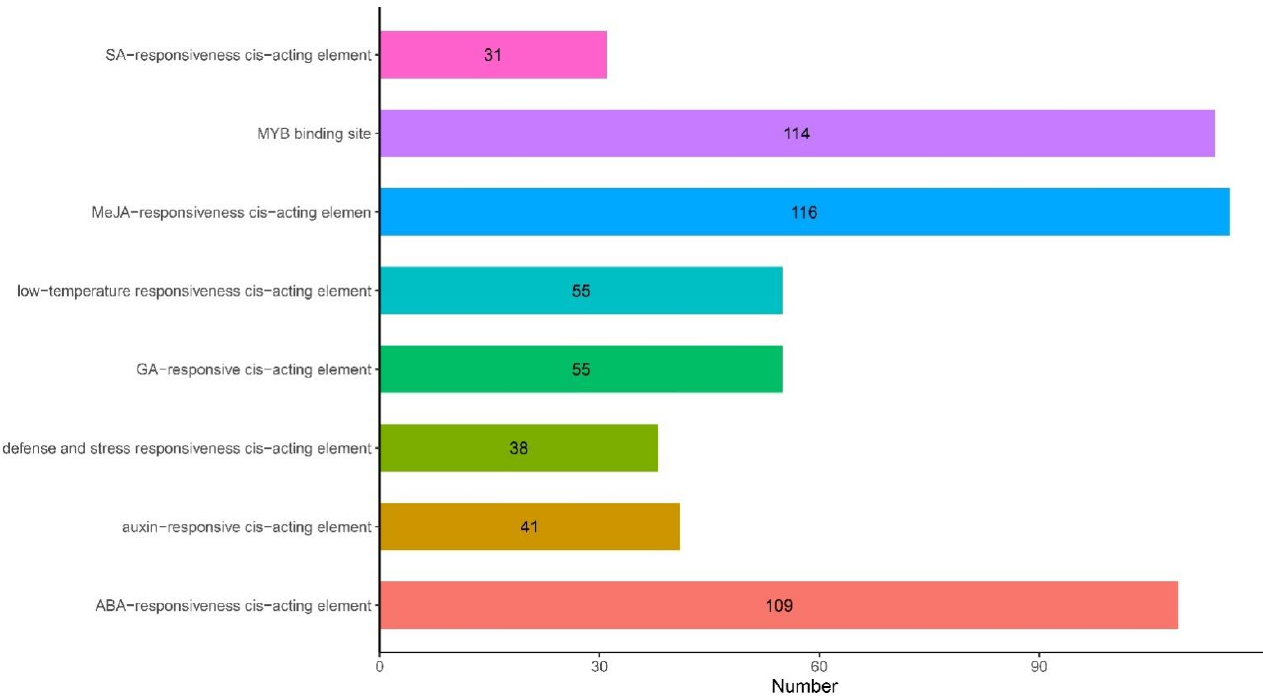
Figure 4. Quantitative analysis of the cis-acting elements in the promoter regions of G. barbadense ANR family genes.